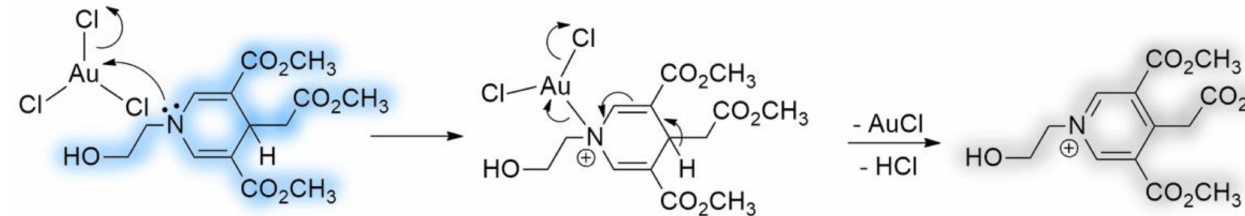
Figure 7. 1 H NMR spectra of DHP-OH (0.03 mmol) in D 2 O:DMSO- d6 (99:1, v / v ) ( a ) before and ( b ) after addition of Au 3+ .